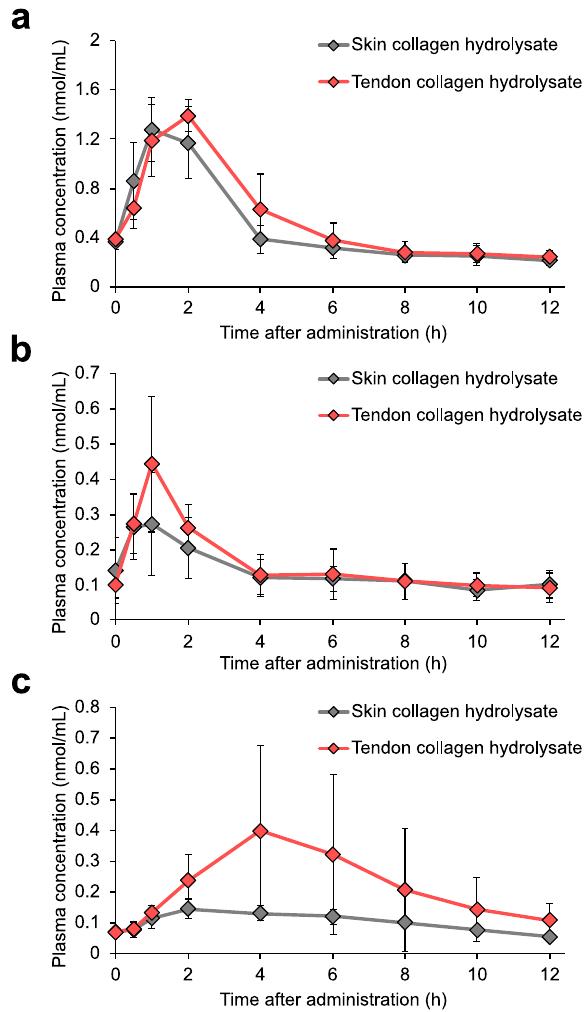
Fig. 5 Concentrations of Hyp-containing oligopeptides in mouse plasma after oral administration of collagen hydrolysate prepared from bovine skin or tendon. Mouse plasma samples collected before (0 h) and 0.5, 1, 2, 4, 6, 8, 10, and 12 h after the administration of bovine skin or tendon collagen hydrolysate were analyzed by LC − MS in MRM mode for quantitation of a Pro-4Hyp, b 4Hyp-Gly, and c Gly-3Hyp-4Hyp. The data represent the mean ± SD ( n =